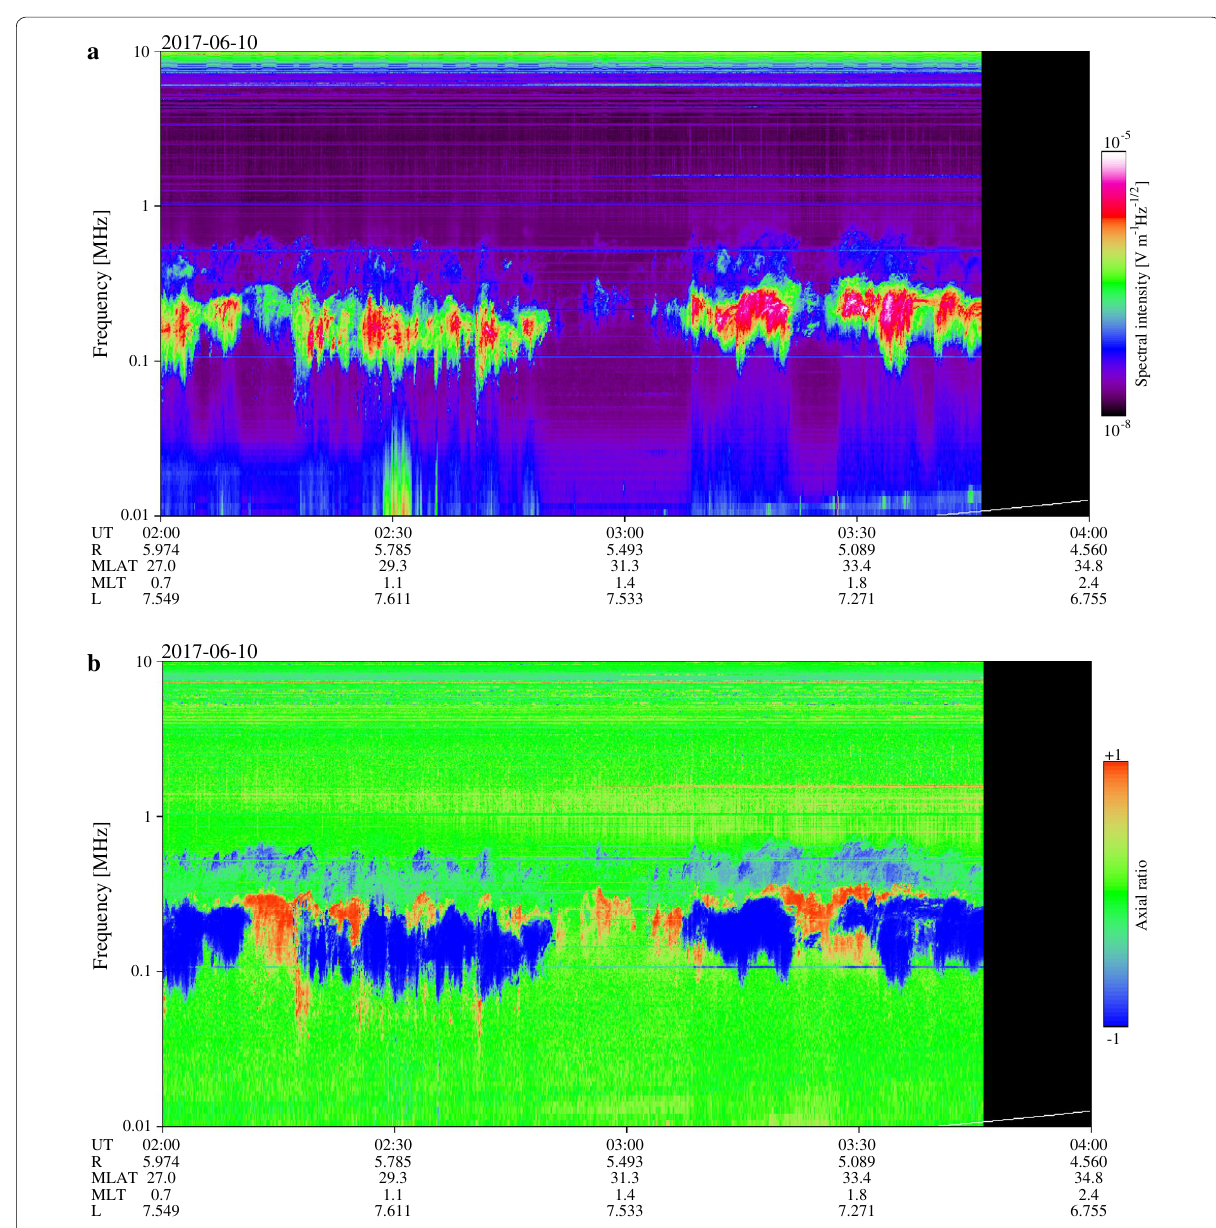
Fig. 6 Intensity ( a ) and axial ratio ( b ) of AKR measured on June 10, 2017. Right- and left-handed radio waves with respect to the background mag- netic field are indicated in blue and red,